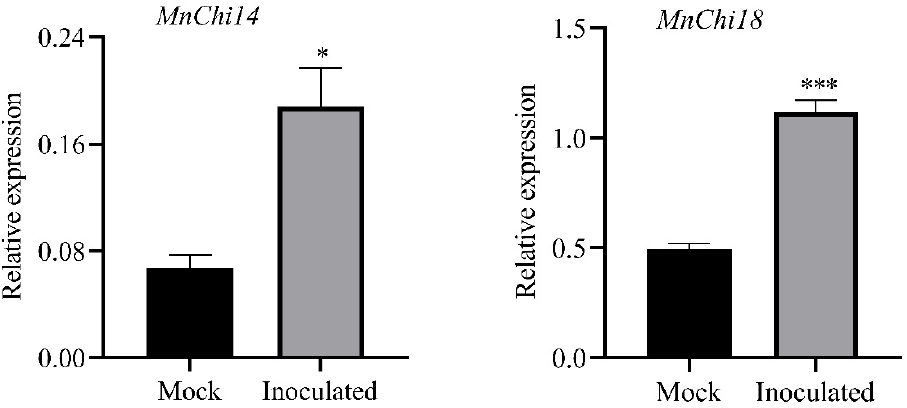
Figure 3. Relative expression of MnChi14 and MnChi18 in mock-treated (Mock) and B. cinerea -inoculated (Inoculated) M. notabilis leaves. Error bars indicate the standard deviation, n = 3 (* p -value < 0.05, *** p -value < 0.001; two-tailed t -test).